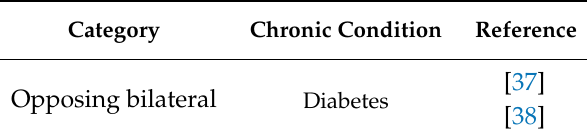
Table 7. Opposing bilateral chosen examples.